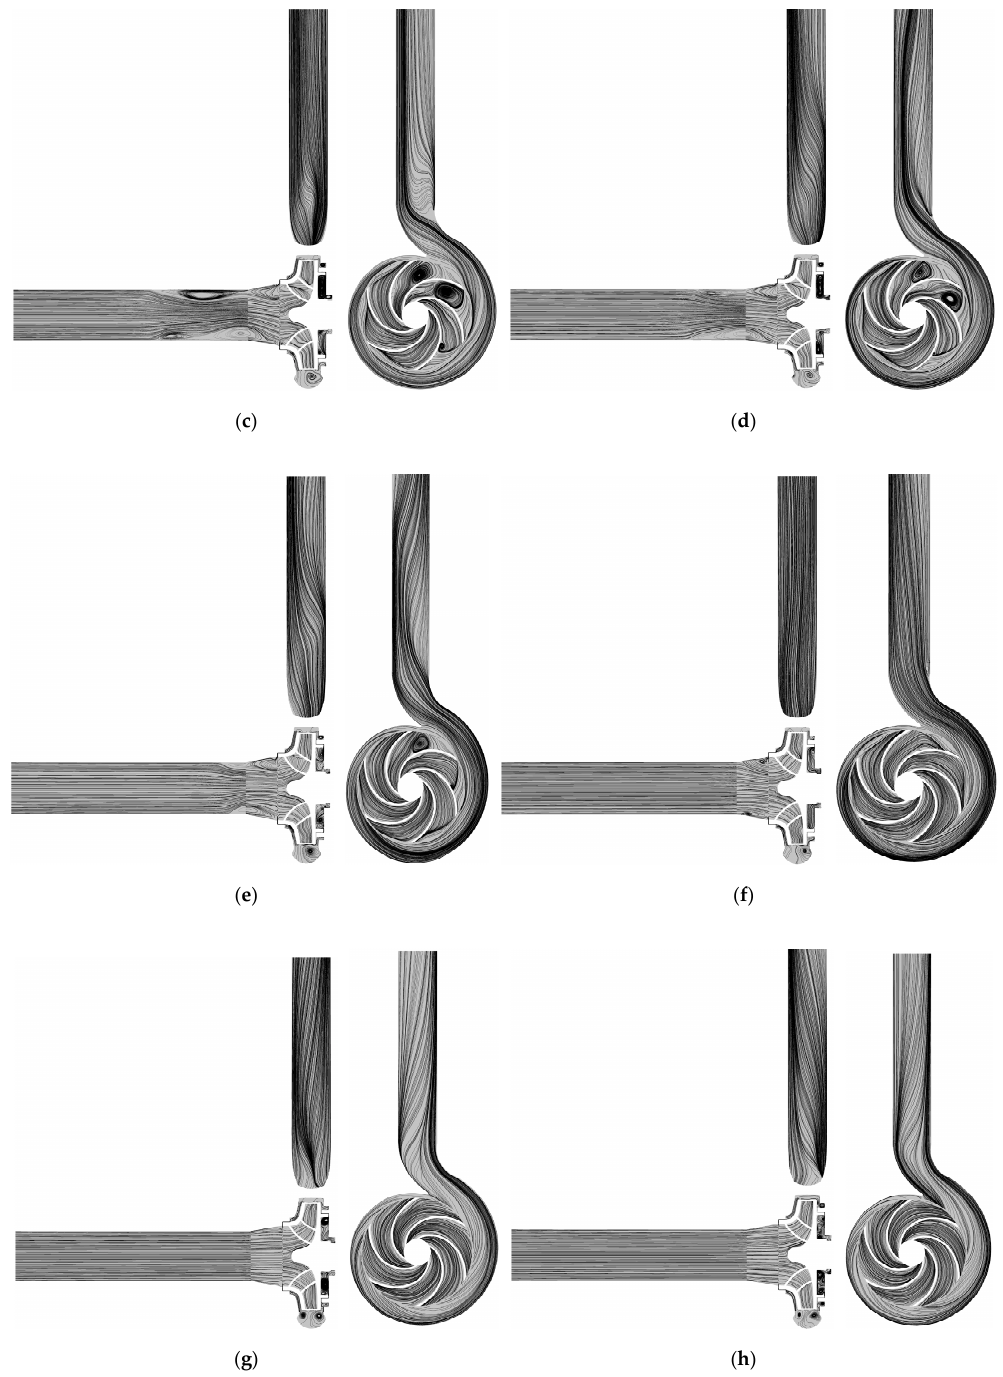
Figure 8. The streamlines of water velocity distributed in plane A and plane B. ( a ) 0 m 3 /h, 0 Q d ; ( b ) 8 m 3 /h, 0.16 Q d ; ( c ) 10 m 3 /h, 0.2 Q d ; ( d ) 14 m 3 /h, 0.277 Q d ; ( e ) 20 m 3 /h, 0.4 Q d ; ( f ) 30 m 3 /h, 0.6 Q d ; ( g ) 50.6 ( b ) 8 m 3 / h, 0.16 Q d ; ( c ) 10 m 3 / h, 0.2 Q d ; ( d ) 14 m 3 / h, 0.277 Q d ; ( e ) 20 m 3 / h, 0.4 Q d ; ( f ) 30 m 3 / h, 0.6 Q d ; m 3 /h, 1.0 Q d ; ( h ) 67 m 3 /h, 1.32 Q d . ( g ) 50.6 m 3 / h, 1.0 Q d ; ( h ) 67 m 3 / h, 1.32 Q d